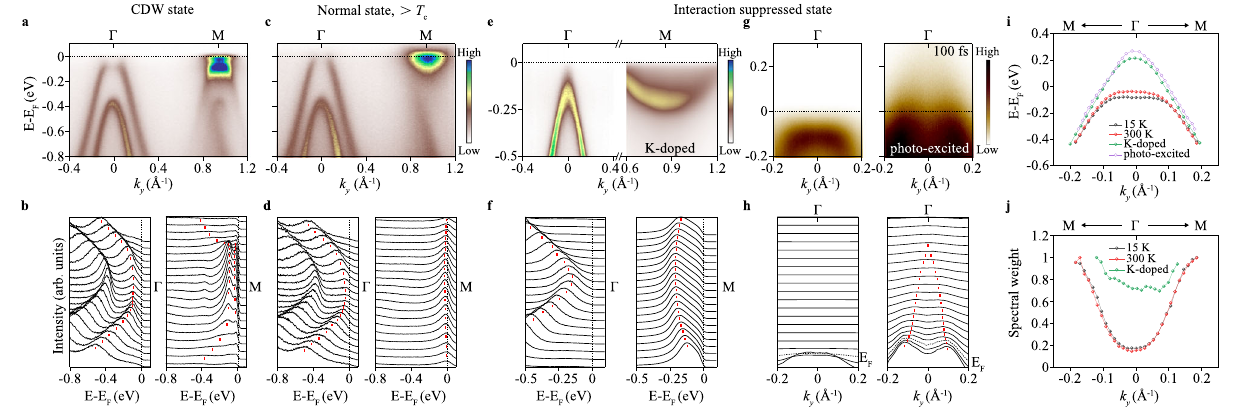
Fig. 3 | The two-step process of the CDW formation in monolayer 1T-ZrTe 2 . a , c ThebandstructuresmeasuredbyARPESalongthe Γ -Mdirectionat15K( a )and 300K ( c ) using 50.6eV synchrotron radiation light. e ARPES data along the Γ -M direction taken from surface K-doped sample with a carrier density of 0.14 e − /Zr atom. The corresponding EDCs are shown in ( b , d , f ) respectively. g ARPES snap- shotstakenbeforeopticalpumpingandatcharacteristicpump-probedelaysatthe Γ point. h MDCs for the data shown in ( g ). i , j Band position (bands are shifted by